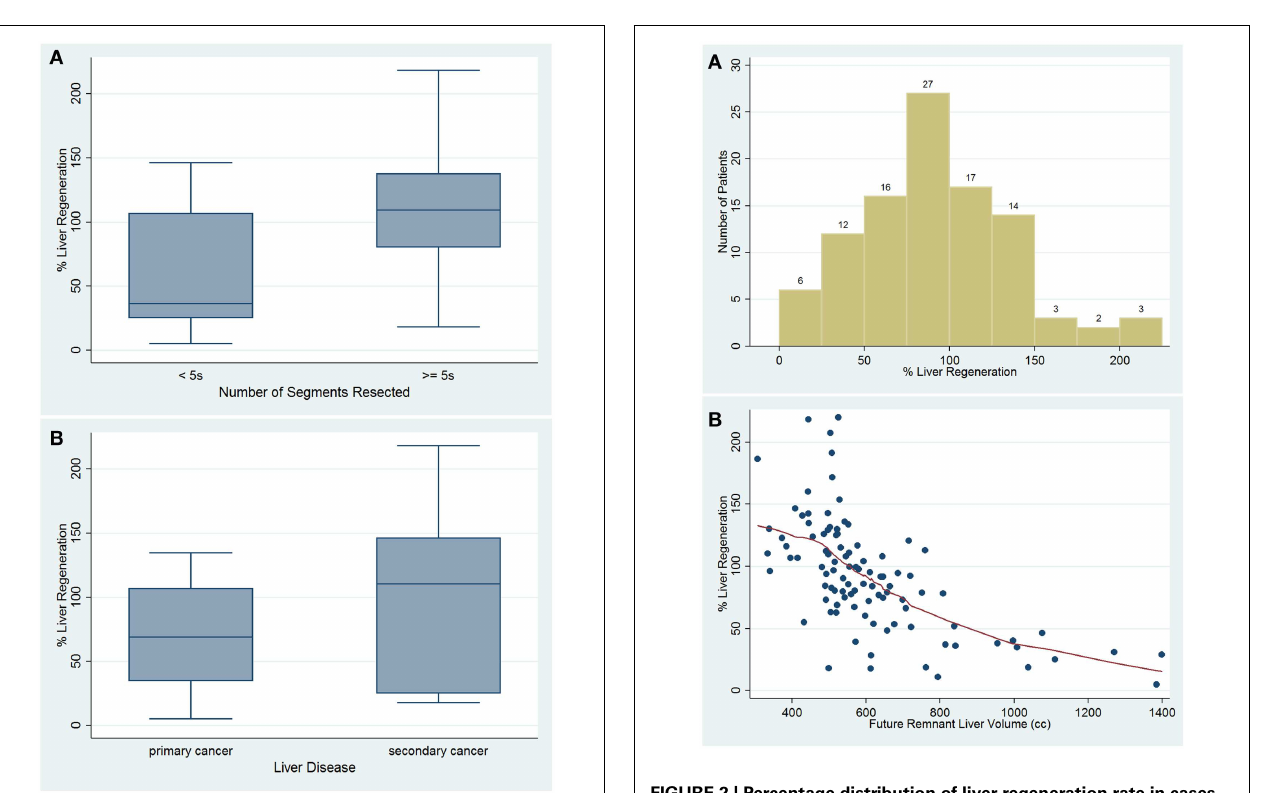
51.646, 106.854), showing no significant difference ( p = 0.285).